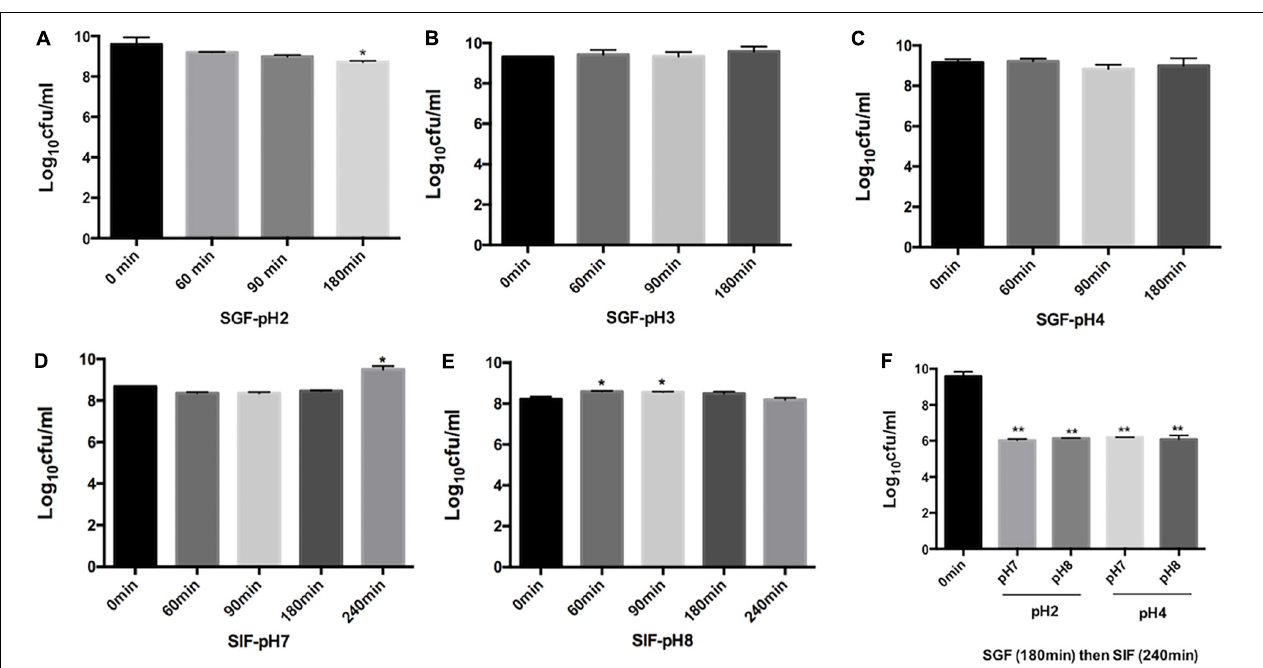
FIGURE 1 | Effect of simulated gastric juices SGF [pH 2 (A) pH 3.0 (B) , pH 4.0 (C) ] and simulated intestinal juice SIF [pH7 (D) , pH 8 (E) ] on the viability of R. badensis subsp. acadiensis that was exposed to SGF for 60, 90,and 180 min and to SIF for 60, 90,180, and 240 min. In panel (F) R. badensis subsp. acadiensis was first exposed to SGF for 180 min then to SIF for 240 min. Data represents mean log10CFU/ml ± SEM ( n = 3). Significant difference exists if * p < 0.05, ** p < 0.01.